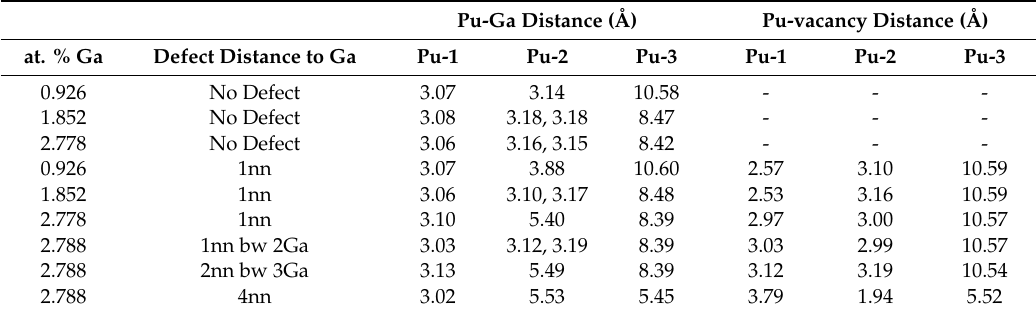
Table 3. Pu-Ga and Pu-vacancy distances in various at. % Ga concentrations and defect structures represented in the partial density states in Figures 8–10. Note: bond lengths are contracted from experimental bond lengths due to a contracted lattice at 0K as shown in Figure 2. Pu-Ga Distance (Å) Pu-vacancy Distance (Å) at. %